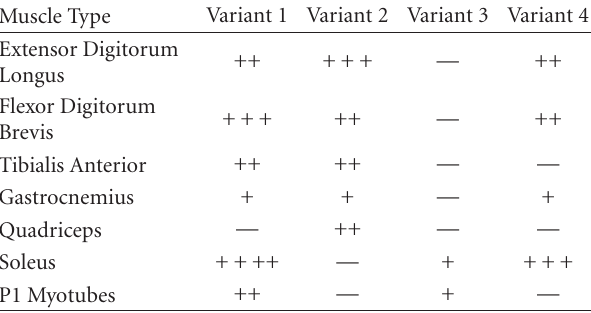
Table 2: MyBP-C slow variants 1–4 are present in varying amounts in di ff erent skeletal muscles. A plus (+) sign indicates the presence of the respective variant in a select muscle. The relative abundance of variants 1–4 in the skeletal muscles tested is illustrated by the number of plus